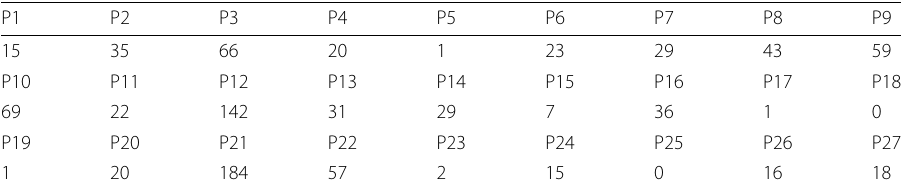
Table 1 Number of cross talks events for each patient detected by the naive sliding window